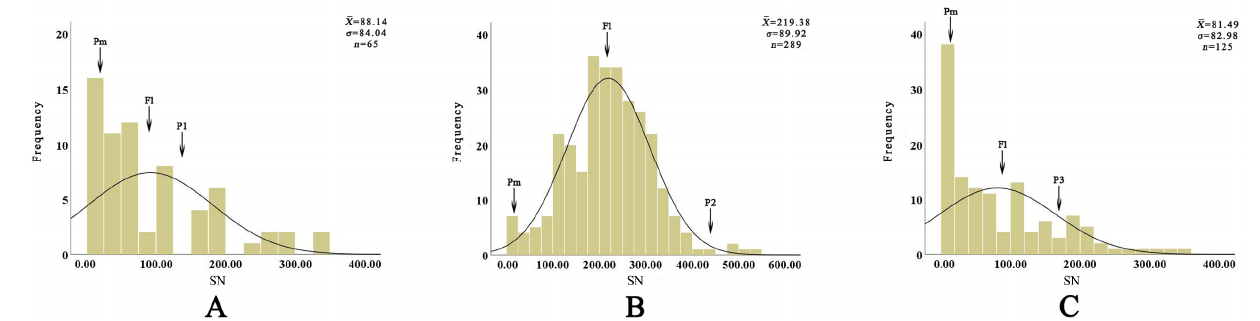
Figure 7. Frequency distribution diagrams of raised spots number (SN) for F1 plants. ( A – C ): spots number of F1 plants in combinations EW01, EW02, and EW03; X -coordinate: spots number (SN); Y -coordinate: frequency; F1 and X : mean value of hybrids; σ : standard deviation; n: number of individuals; Pm: spots number of maternal parent; P1, P2, and P3: spots number of paternal parents EW01, EW02, and EW03. Table 4. Heterosis analysis of spots number in three cross combinations.